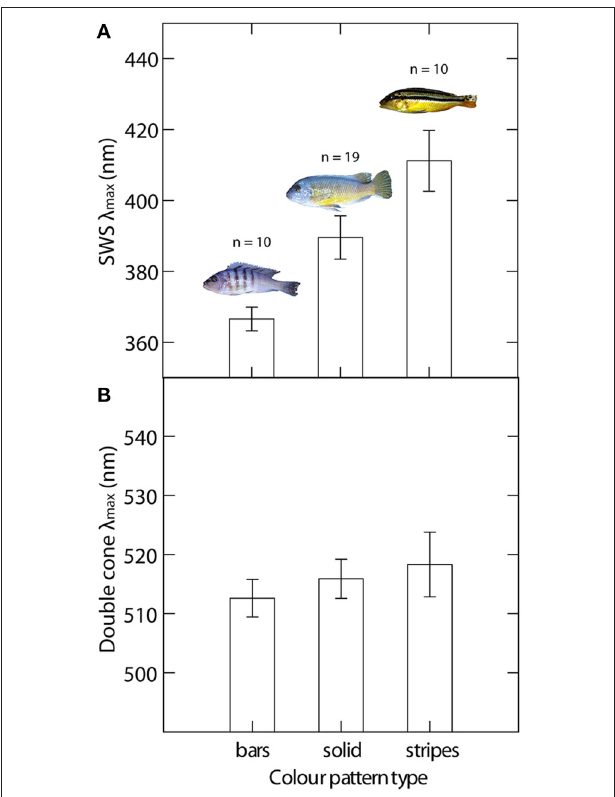
FIGURE 4 | The relationship between color pattern and photoreceptor sensitivity of Lake Malawi cichlids. (A) SWS photoreceptor sensitivity; (B) double cone maximal sensitivity. Inset pictures show examples of each color pattern type (bars, Metriaclima zebra ; solid, Labeotropheus c.f. fuelleborni “Katale”; stripes, Melanochromis auratus ). Error bars = standard